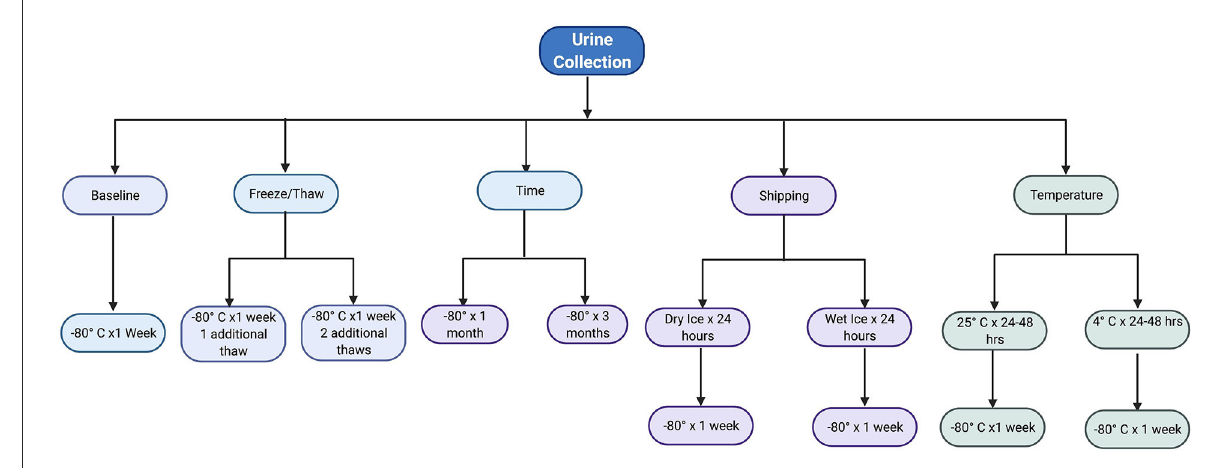
FIGURE1 Flowchart of the 10 experimental conditions per urine sample. Image made with